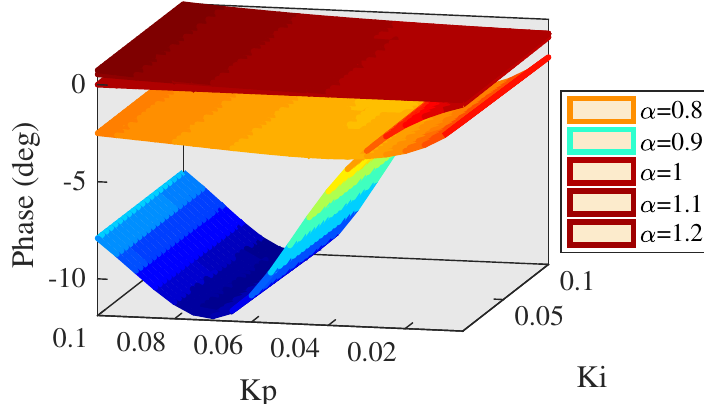
Figure 16. Phase of AMFC ( α = 0.8 to 1.2).